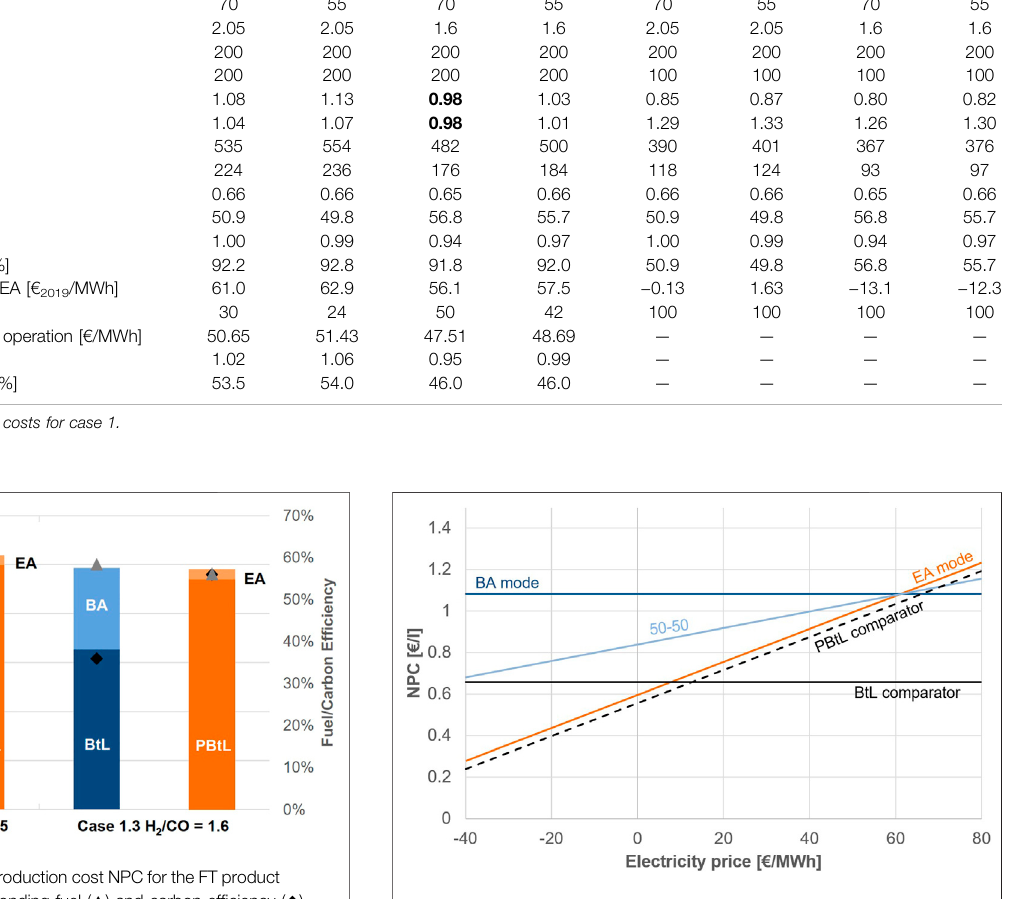
TABLE 6 | Net production cost NPC and fi xed capital investment FCI for all studied cases. Case number